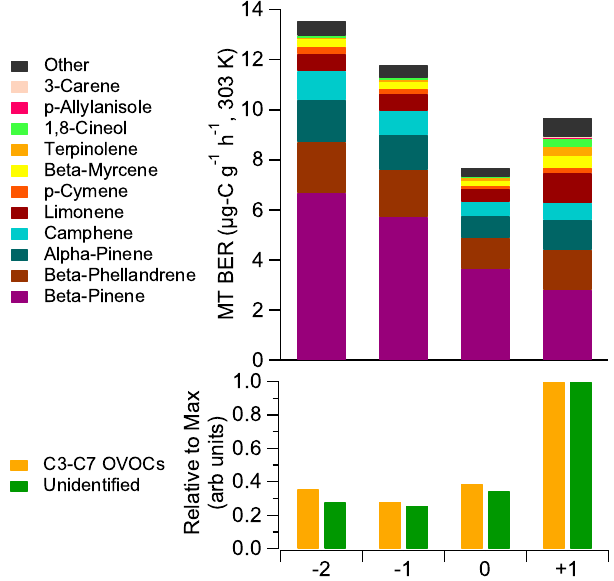
Figure 9. Grand fir BVOC profile. The x axis denotes the day relative to treatment application. The top panel summarizes the monoterpenoid emissions where the y axis is the monoterpenoid basal emission rate normalized to 303K. The bottom panel summa- rizes the emissions of small oxy-VOCs and other unidentified com- pounds where the y axis is the fraction of the emission rate relative to the maximum measured